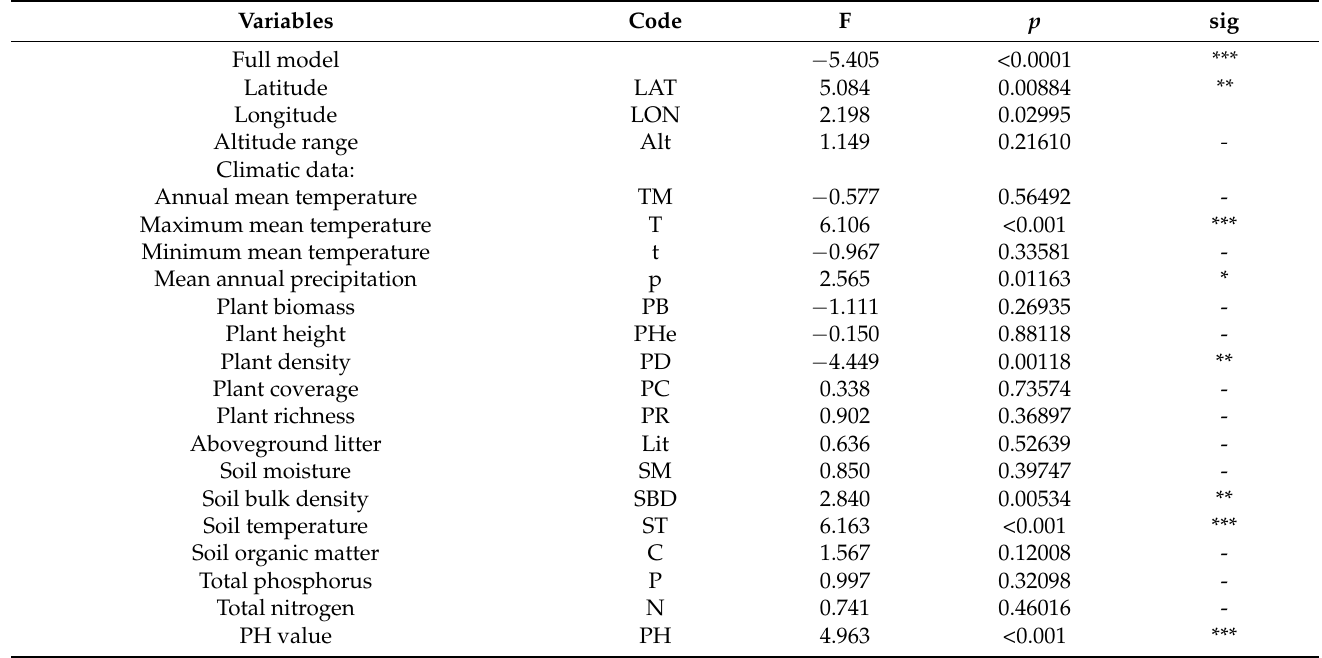
Table A3. The species richness of beetles and environmental factors estimated by variance inflation factor